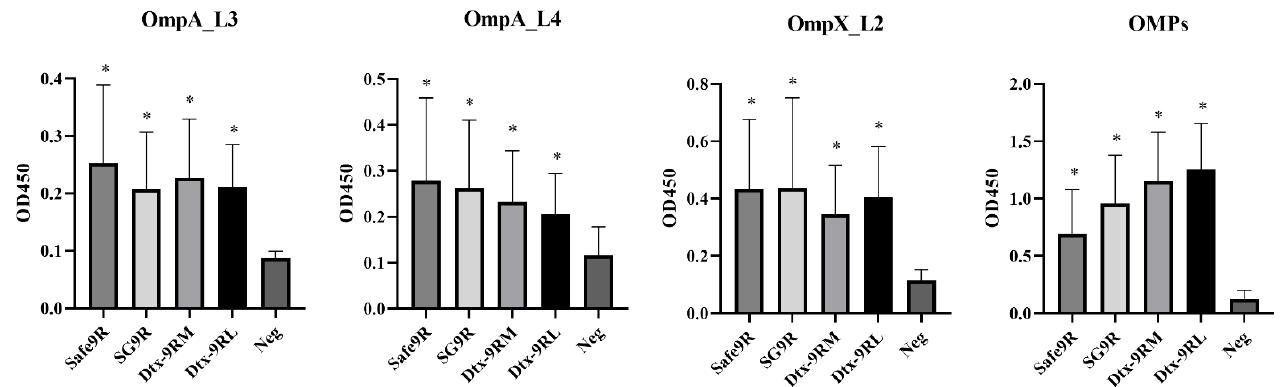
Figure 5. Humoral immunogenicity of oil emulsion vaccines of the detoxified strains. Vaccines were inoculated at 1 week of age, and antibody titers were determined after 2 weeks. * Indicates a significant difference compared with Neg ( p < 0.05).